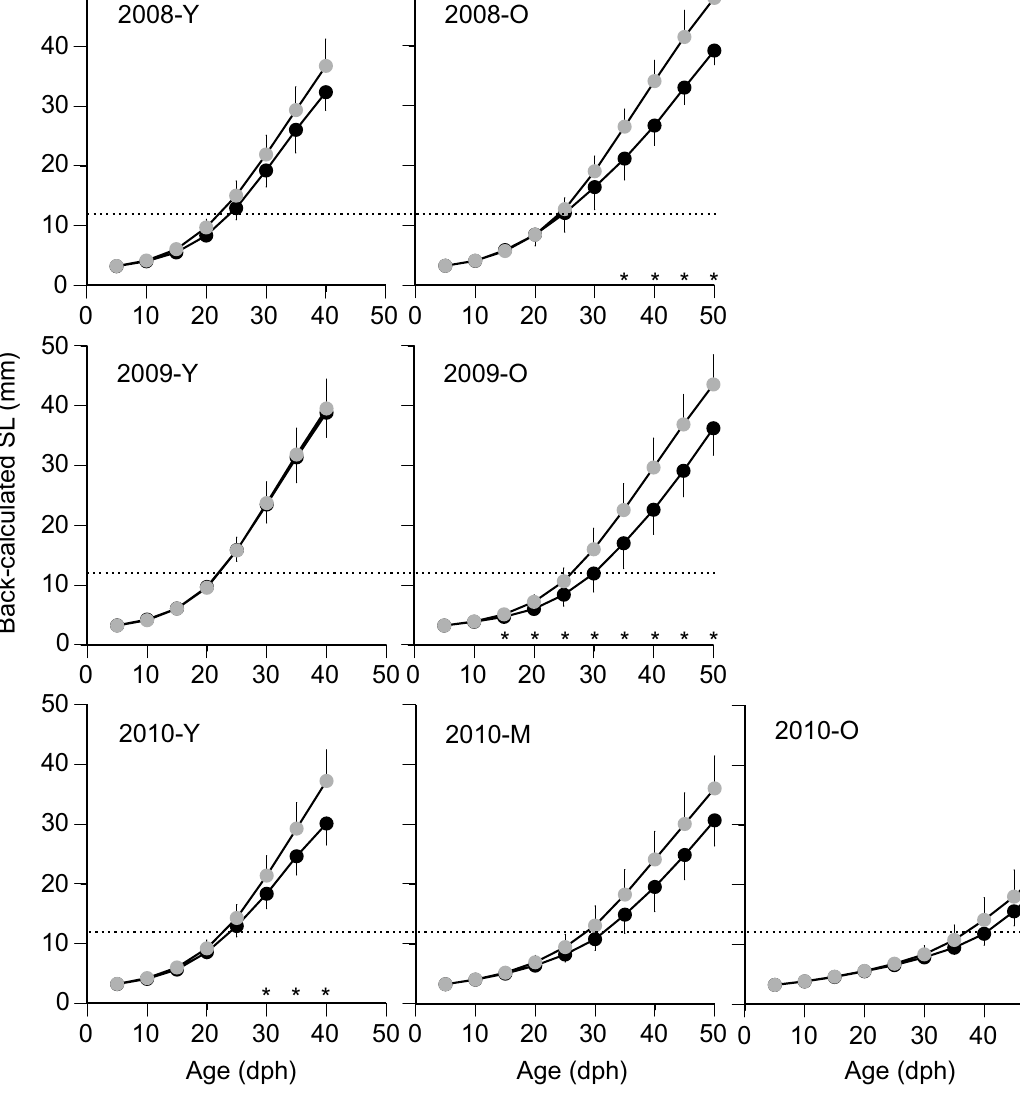
Figure 6. Growth trajectories of the consumed (black) and the netted (grey) juveniles in the young (Y), middle- aged (M), and old (O) groups between 2008 and 2010. Vertical lines indicate the standard deviation of the means. * P < 0.05 in back-calculated standard length (SL) between the consumed and netted juveniles. Horizontal dotted lines indicate SL at Trachurus japonicus metamorphosis from larval to juvenile stages 32